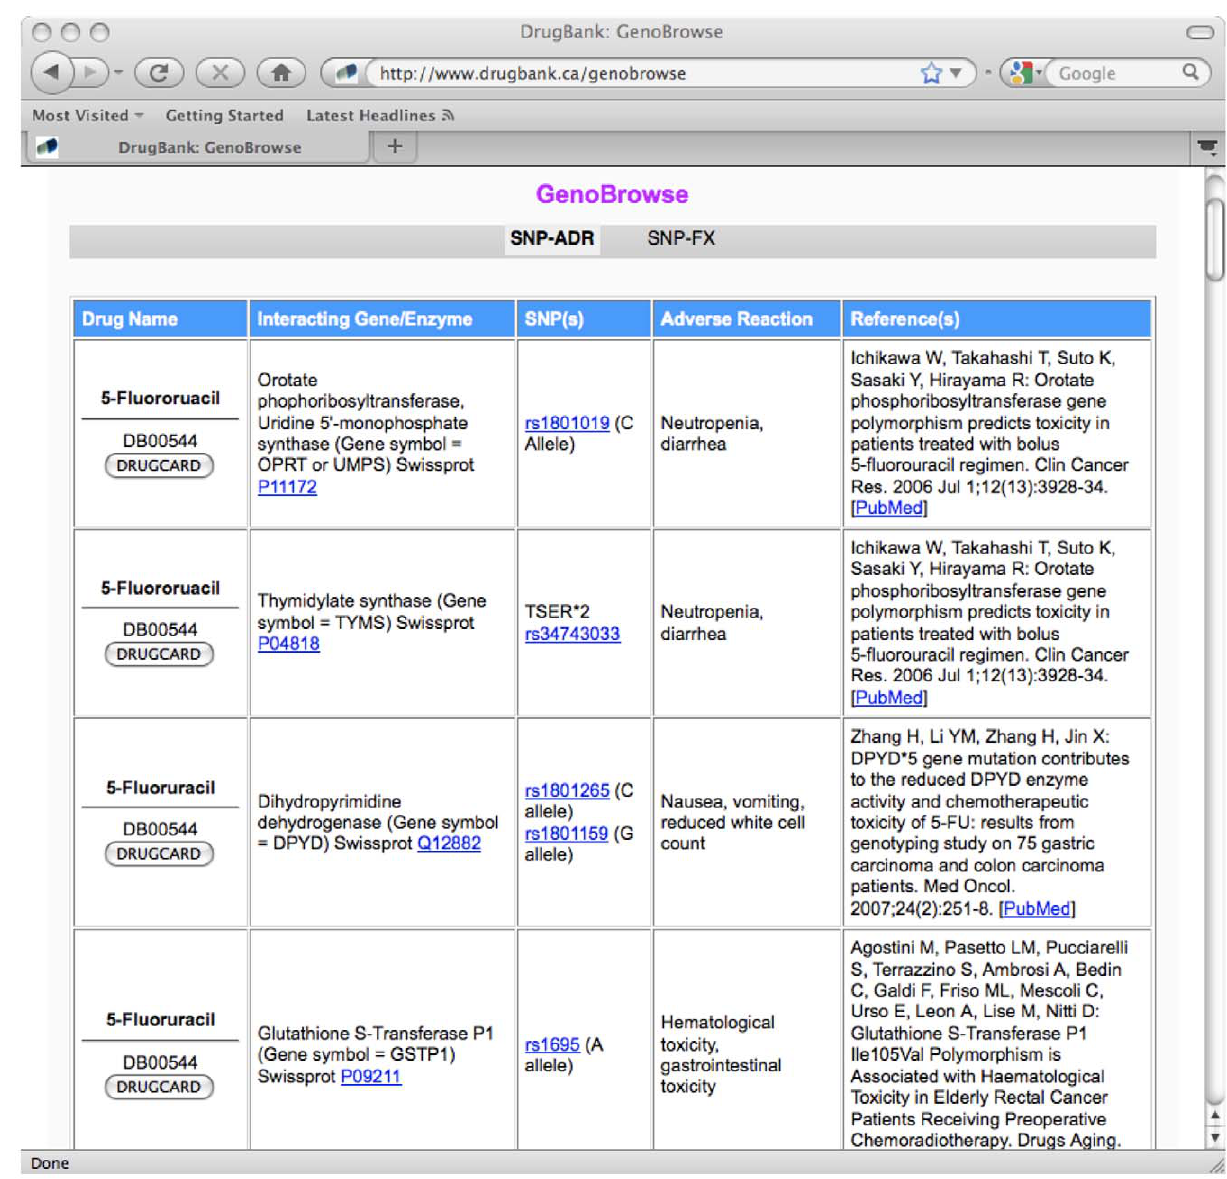
Figure 3. A screen shot of DrugBank’s SNP-ADR table. This displays the information on the adverse drug reactions (ADRs) and associated SNP (single nucleotide polymorphisms) with certain drugs and drug targets